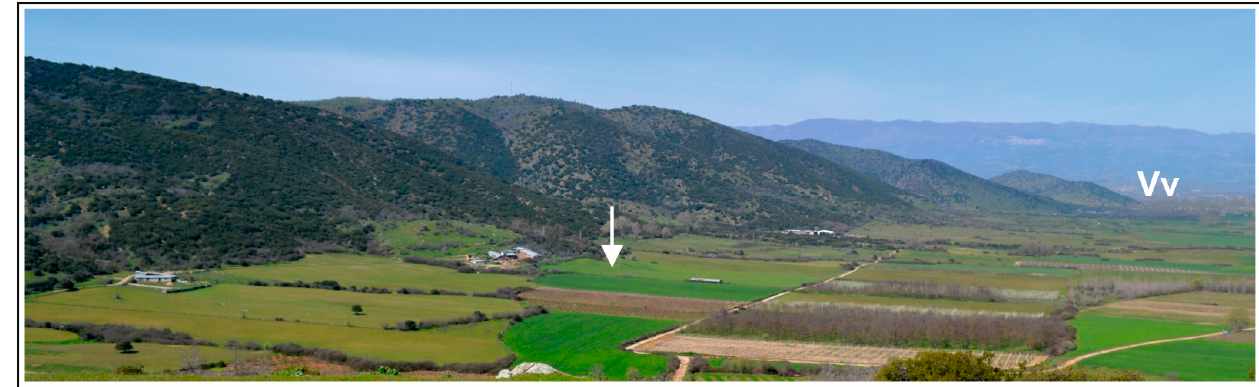
Figure 5. View of straight mountain front with faceted spurs that demarcates VF trace. Photo is taken from Bara Damasiou, looking west towards Vlachogianni village (Vv). Note series of facets exposed on footwall of fault. White arrow shows area where a sheep shepherd reported luminous aerial phenomena and waves on ground surface.